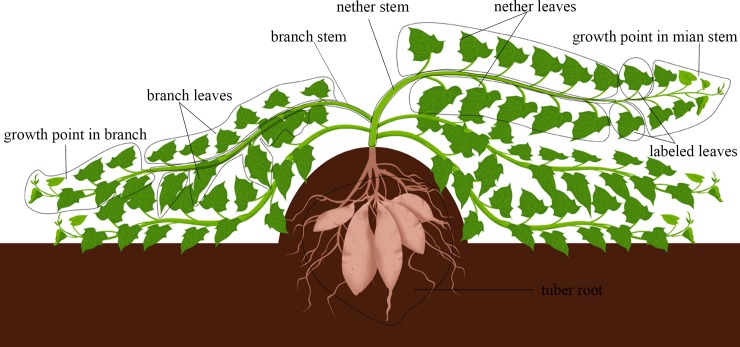
The description of 13C labeling sampling.